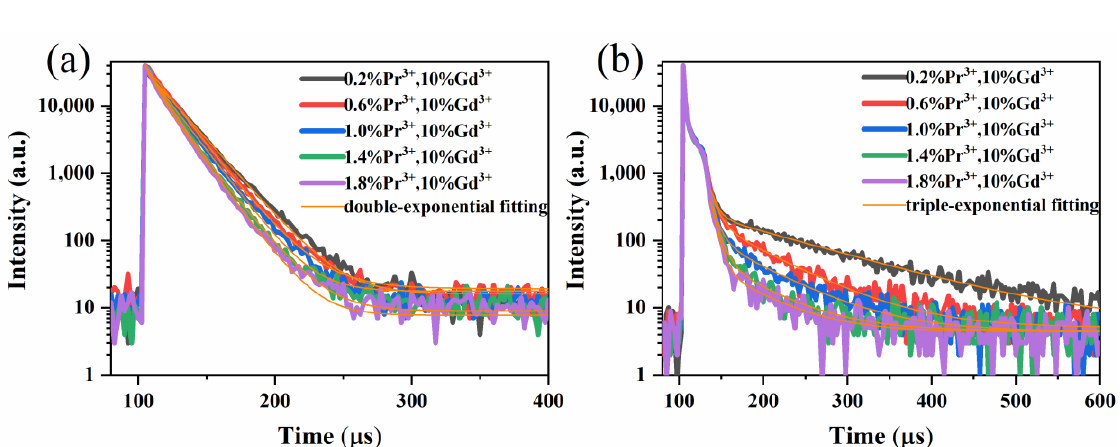
Figure 7. ( a ) 3 P 0 decay curves (λ ex = 446 nm, λ em = 496 nm). ( b ) 1 D 2 decay curves (λ ex = 580 nm, λ em = 602 nm) of the Y 7 O 6 F 9 :xPr 3+ , 10%Gd 3+ (x = 0.2%, 0.6%, 1.0%, 1.4%, 1.8%) phosphors. 3+ , 10%Gd 3+ (x = 0.2%, 0.6%, 1.0%, 1.4%, 1.8%) λ em = 602 nm) of the Y 7 O 6 F 9 :xPr